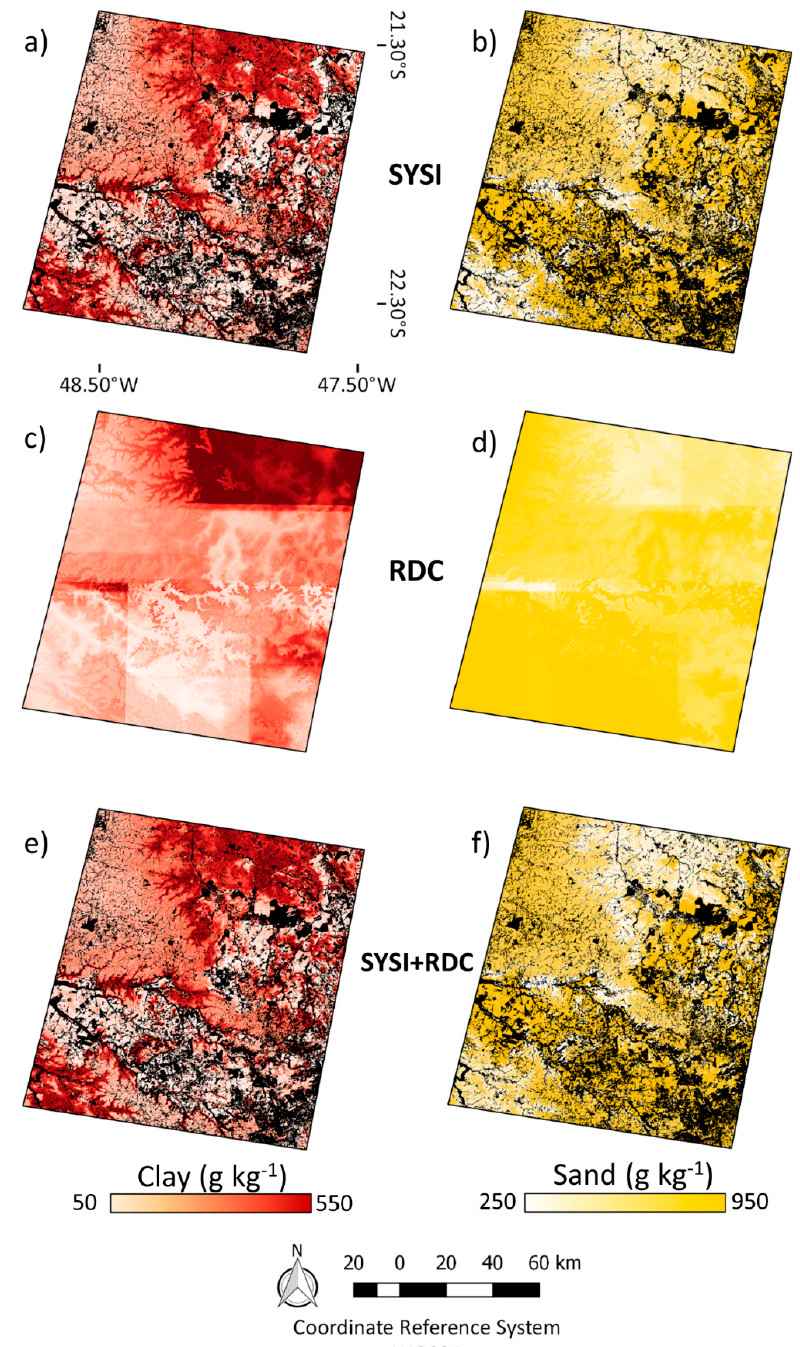
Figure 7. Clay and sand content maps produced from three approaches: using only the Synthetic Soil Image (SYSI) ( a , b ), only the Relief-Derived Covariates (RDC) ( c , d ), and SYSI plus RDC ( e , f ). The maps refer to the models built using the Cubist algorithm. Black color represents unmapped areas.